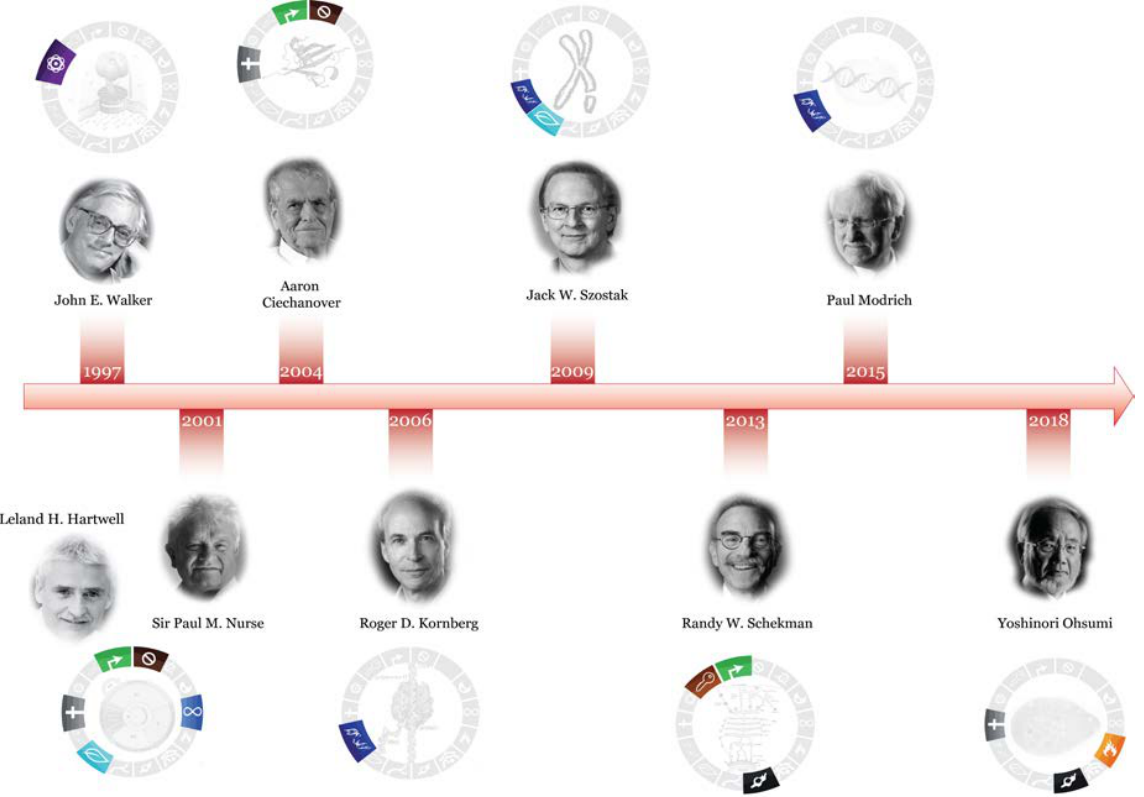
Figure 2. Yeast research in Nobel Prizes and their relation to cancer hallmarks. Symbols for cancer hallmarks are from [38].